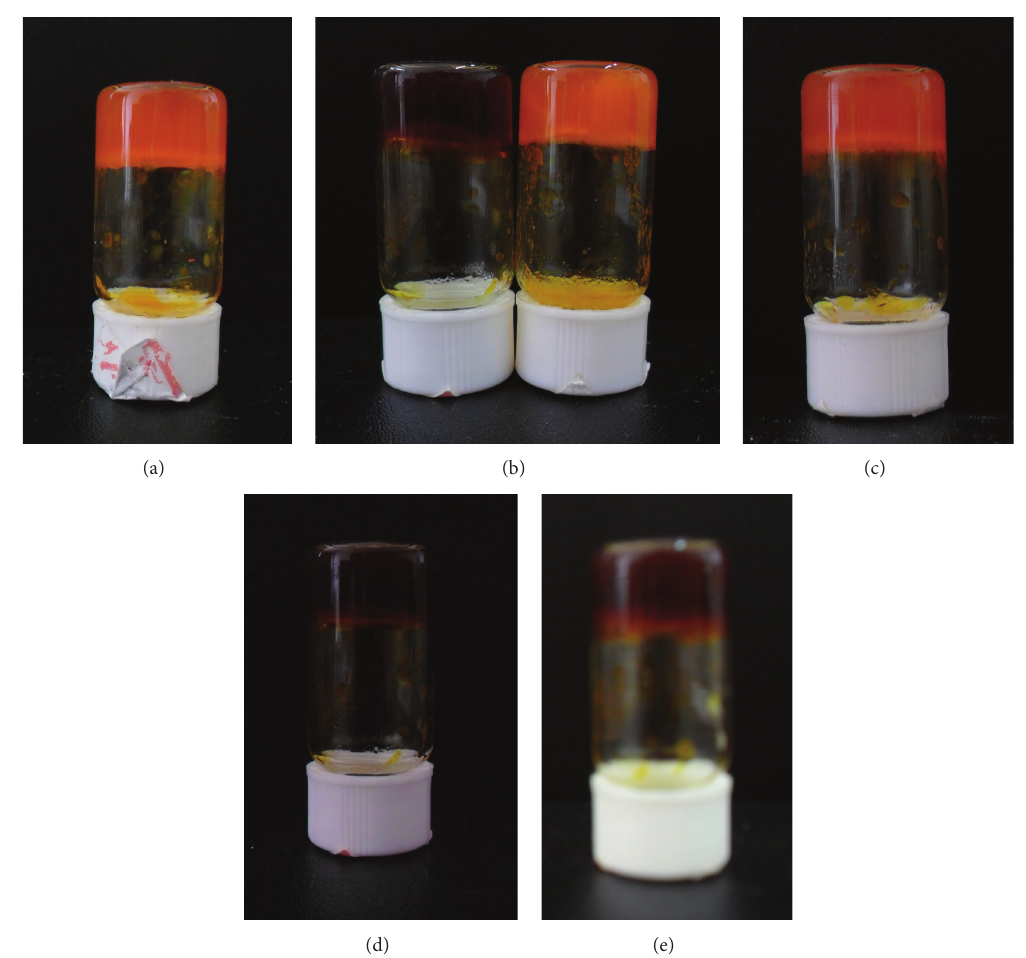
Figure 1: Photographs of as-made organogels: (a) C18-Azo; (b) C16-Azo; (c) C14-Azo; (d) C18-Azo-Me; (e) C16-Azo-Me,